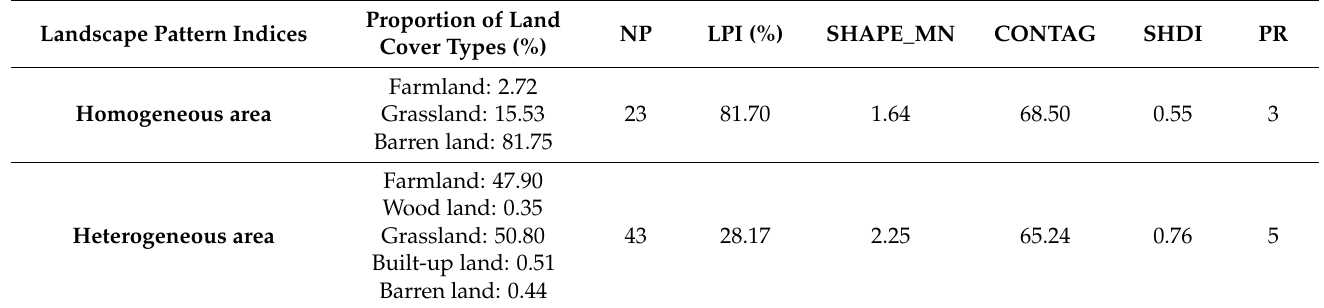
Table 3. Landscape pattern indices and land cover types under different surface conditions. Landscape Pattern